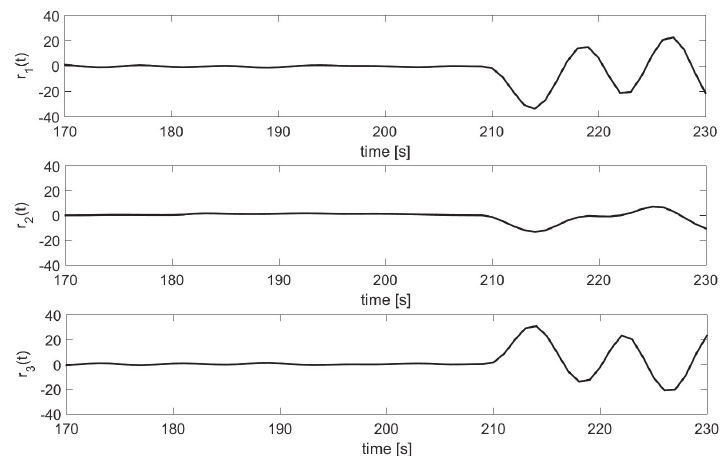
Figure 7. Response of residual to the sensor fault f s 1 .